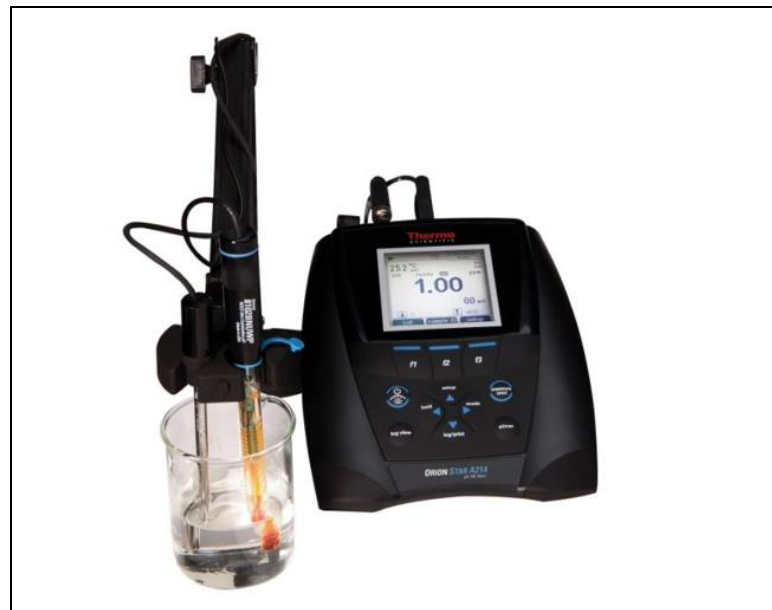
Figure 7. Sample analysis using F-ISE.